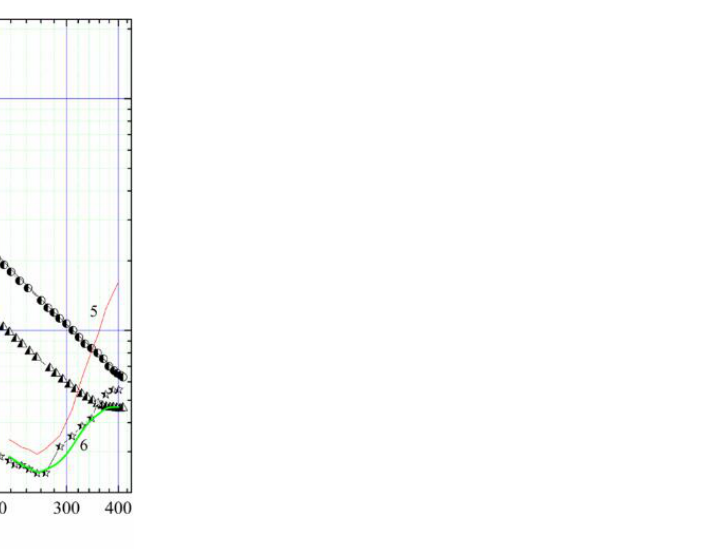
Figure 5. The Hall coefficient versus temperature for as-grown pristine (1), Co-intercalated (2) and Co-doped (3) n -type InSe crystals.